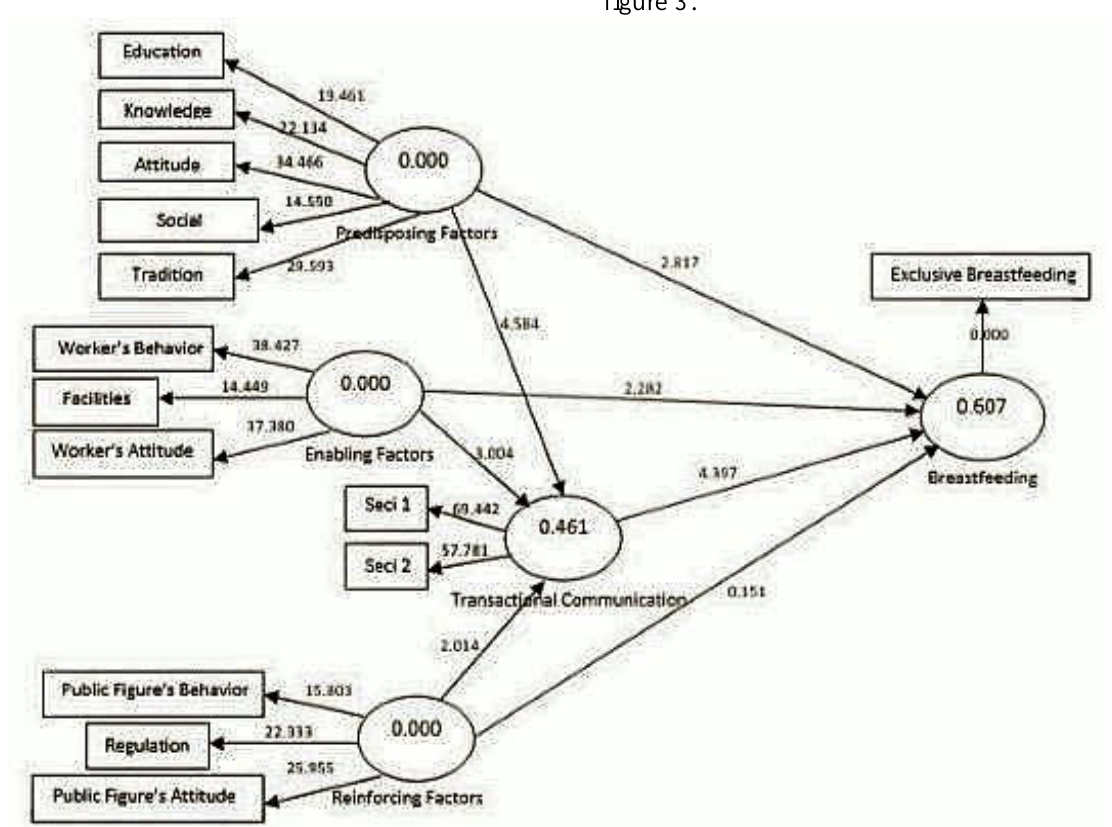
Figure 3. Result of Inner Model Test (Structural Model Stage) Table 5. Path coefficient value and the t-Test among